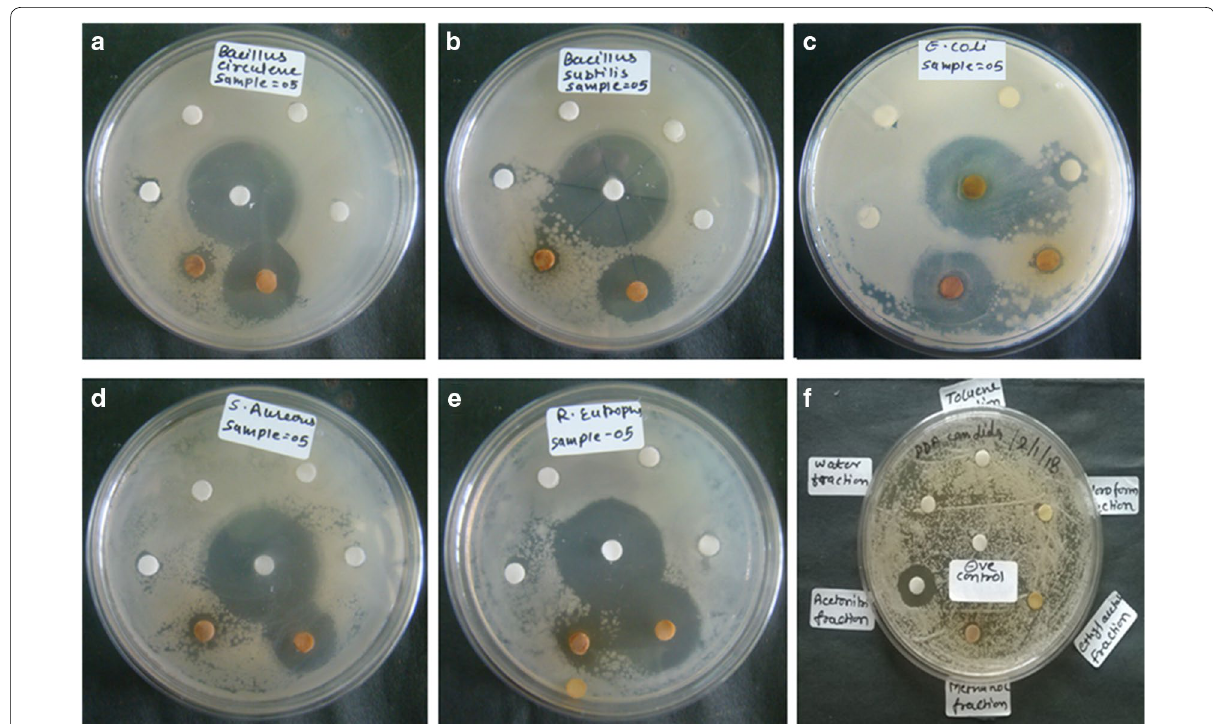
Fig. 5 Antimicrobial activity with zone of inhibition of natural products of Talaromyces purpureogenus isolate- ABRF2 against pathogenic bacterial and fungal strain. a Column fractions against Bacillus circulans. b Column fractions against Bacillus subtilis. c Column fractions against E. coli. d Column fractions against S. aureus. e Column fractions against R. eutropha. f Column fractions against Candida ablicans